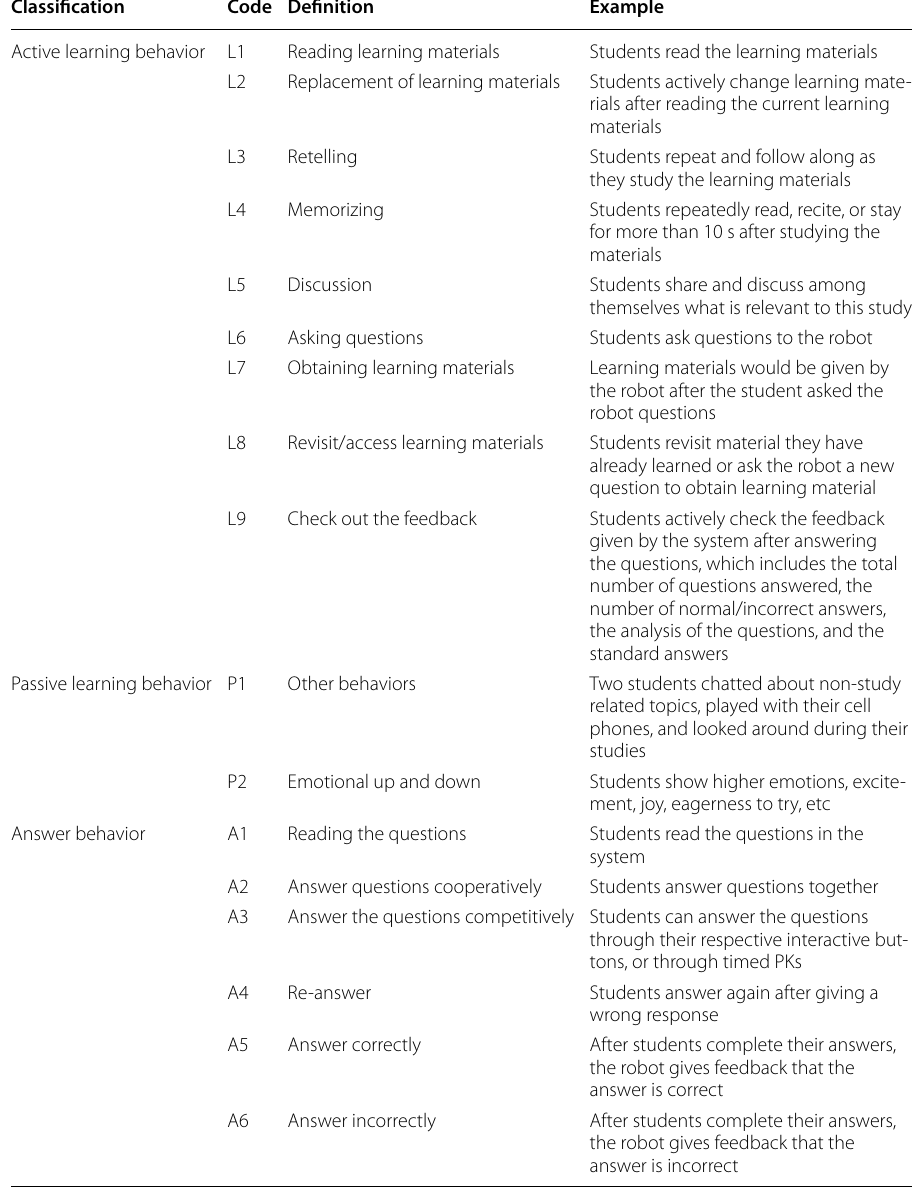
Table 1 Coding scheme for the students’ behaviors